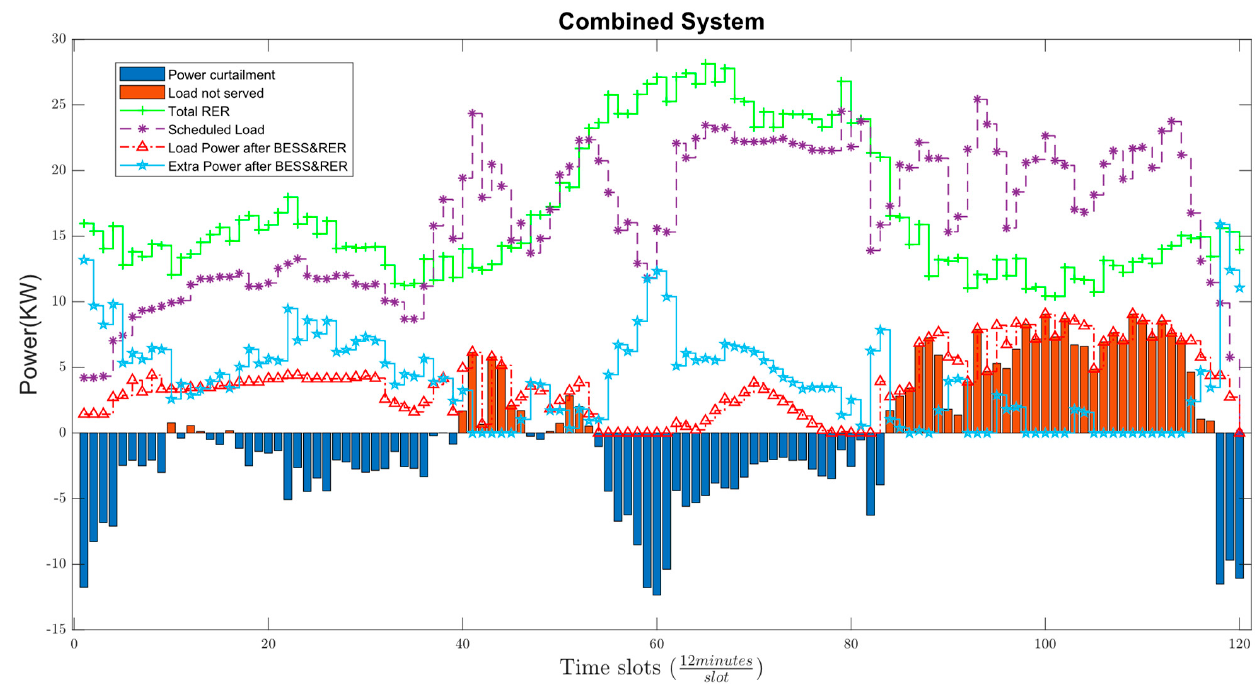
Figure 22. Energy management system for scheduled load using MJLBO.